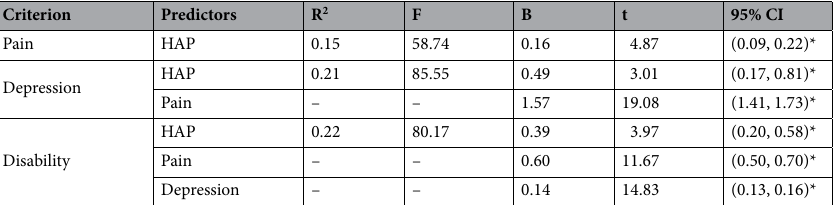
Table 5. Regression coefficients in the serial mediation analysis (N = 5471). *Significant mediator (i.e., zero is not contained within the confidence intervals); sex, age, education level, household income precipitant, marital status, chronic disease status, smoking and drinking status were analyzed as control variable.